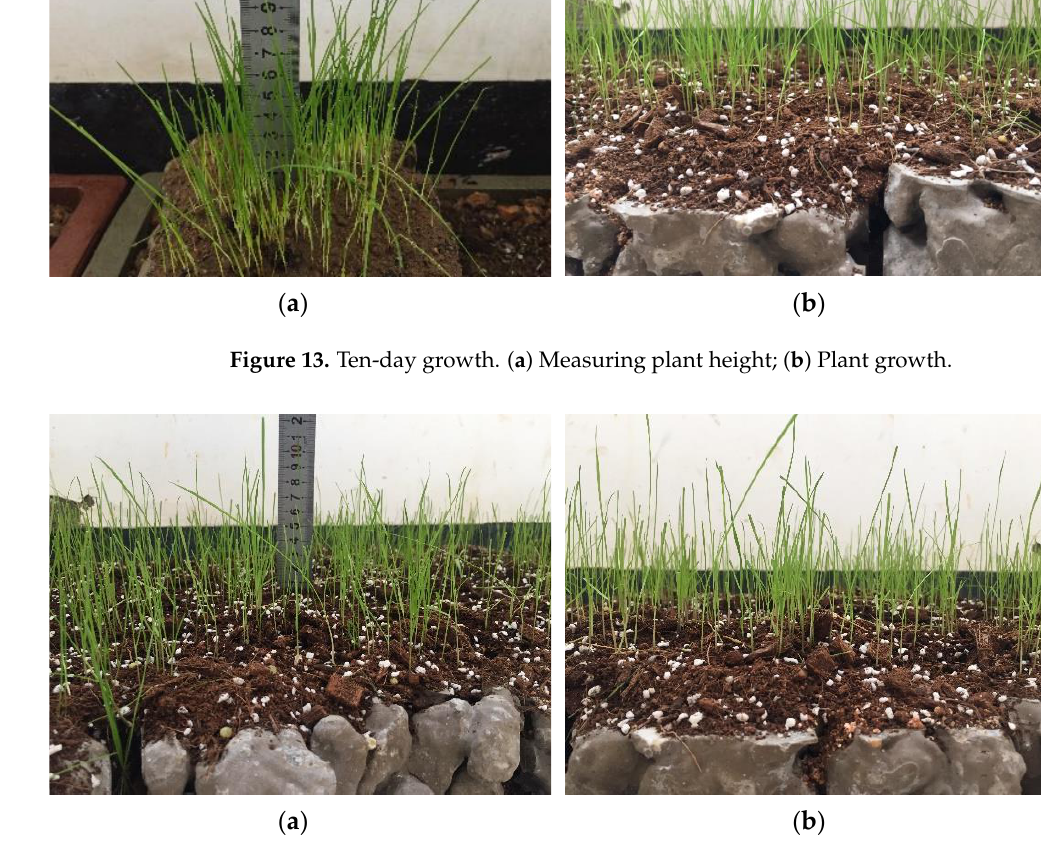
Figure 14. Twenty-five-day growth.( a ) Measuring plant height; ( b ) Plant growth.